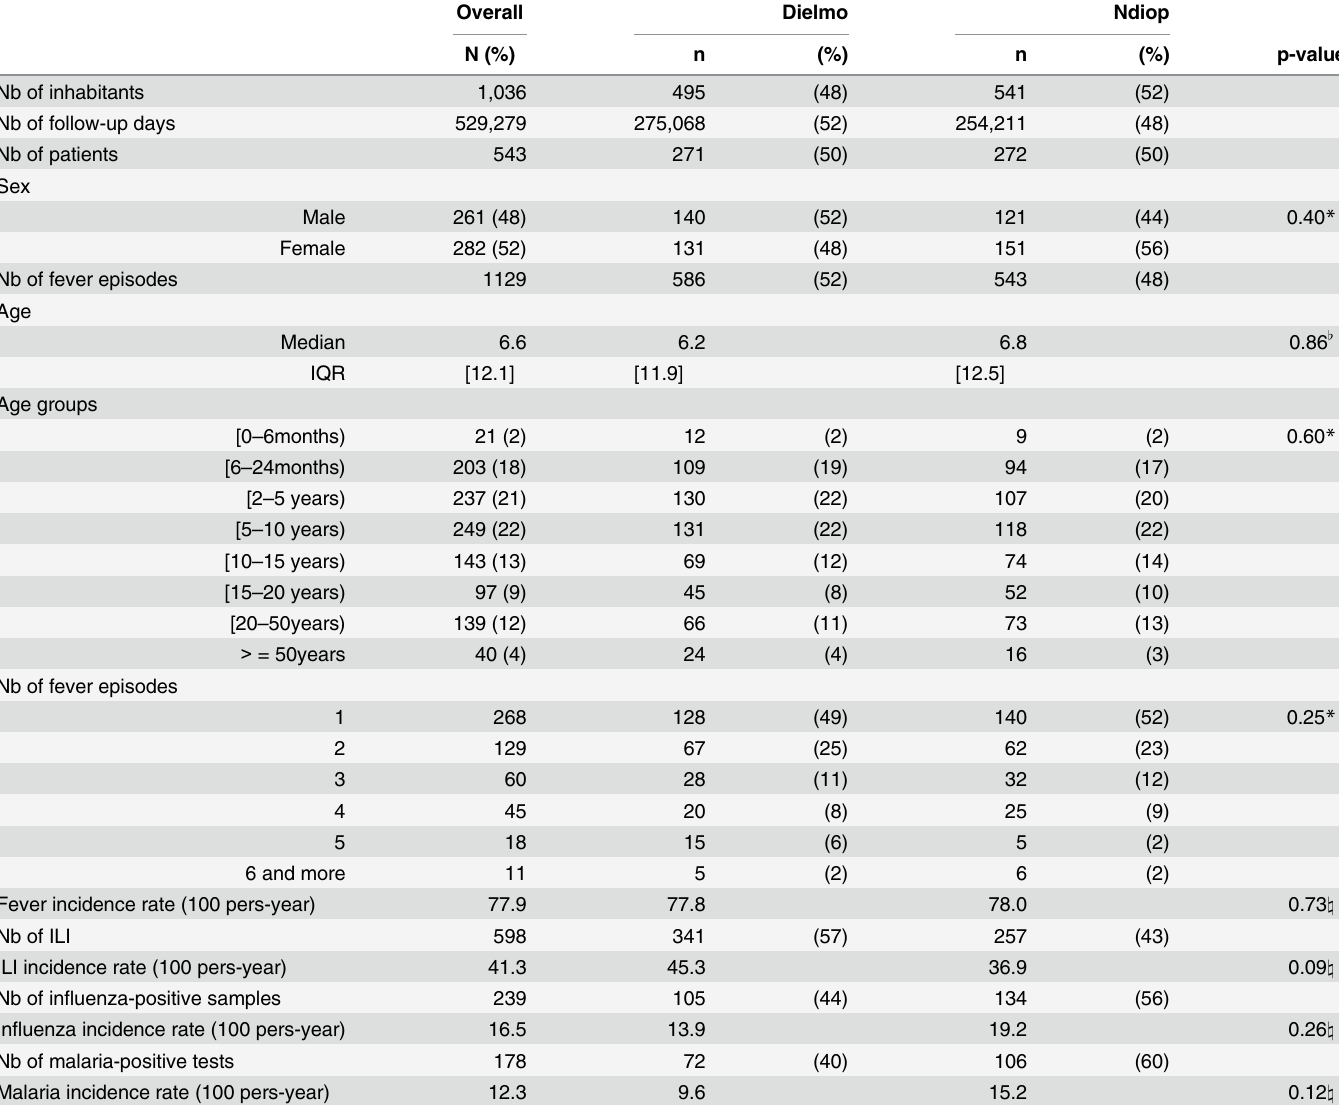
Table 1. Characteristics and incidence rates in the villages of Dielmo and Ndiop — January 2012 – December